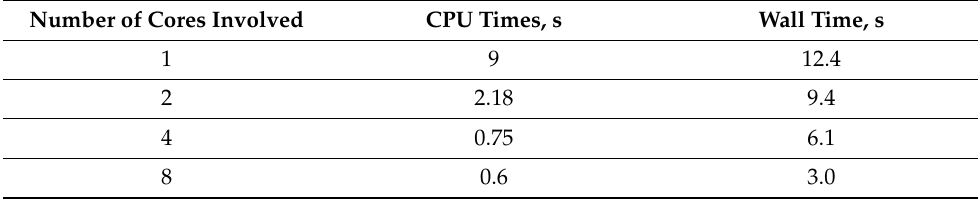
Table 11. The result of parallelizing the learning process across CPU cores for the SVR model. Number of Cores Involved